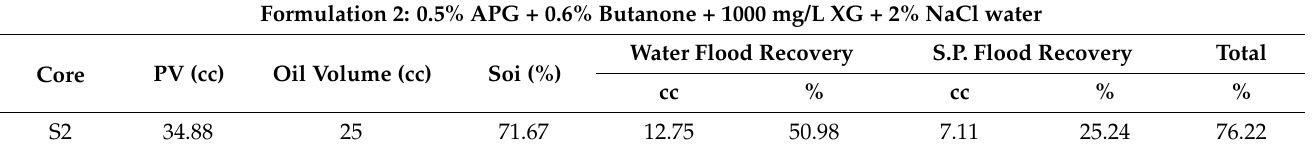
Table 9. Flood Results for Butanone, APG 264, and Xanthan Gum Mixture.